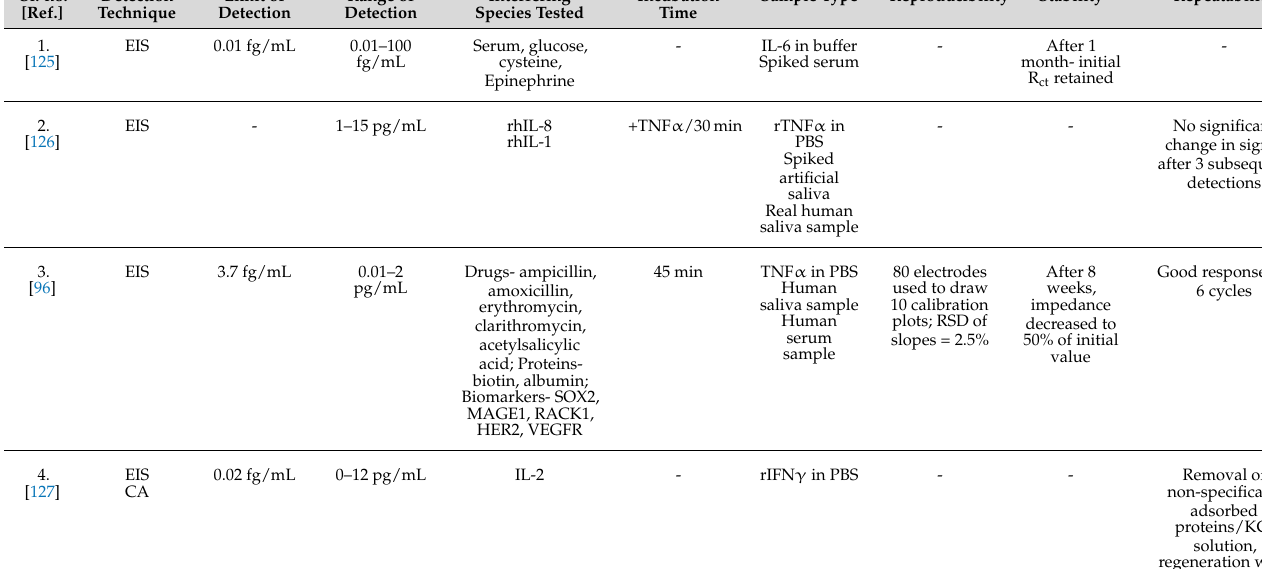
Table 6. SAM-enabled impedimetric immunosensors: Specifications and performance characteristics. Sl. no.